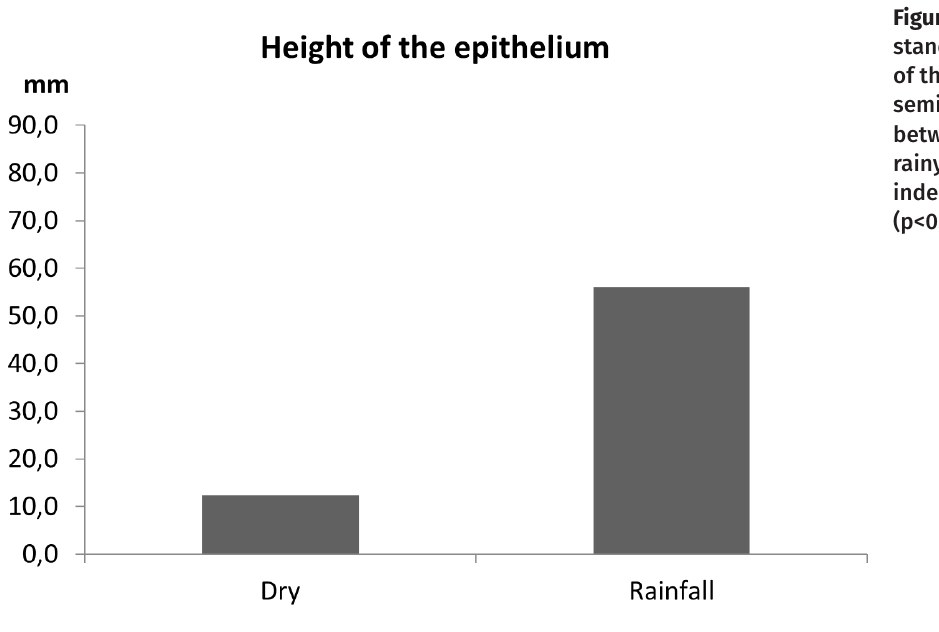
Figure 5. Mean and standard deviation of the heights of seminiferous epithelium between the dry and rainy seasons. T-test for independent samples